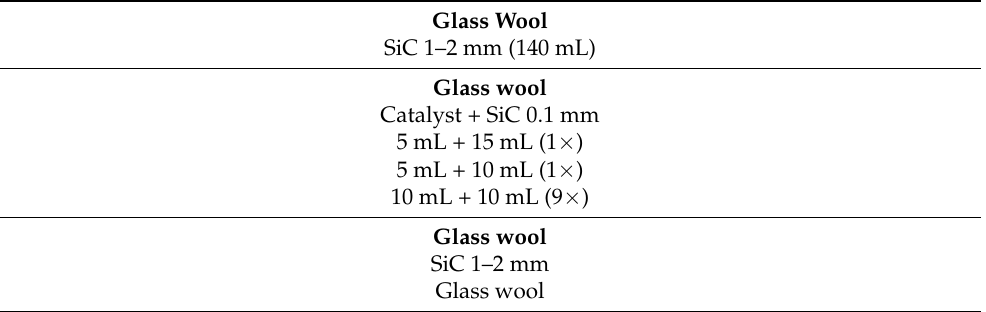
Table 3. Loading diagram.